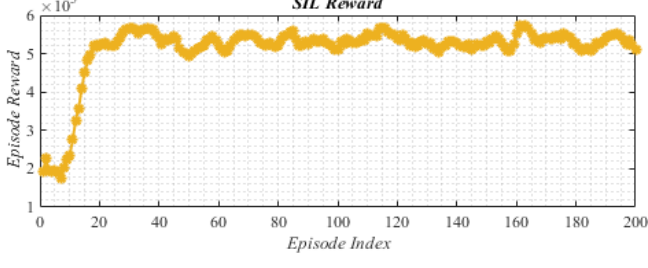
Figure 11. SIL and HIL rewards.